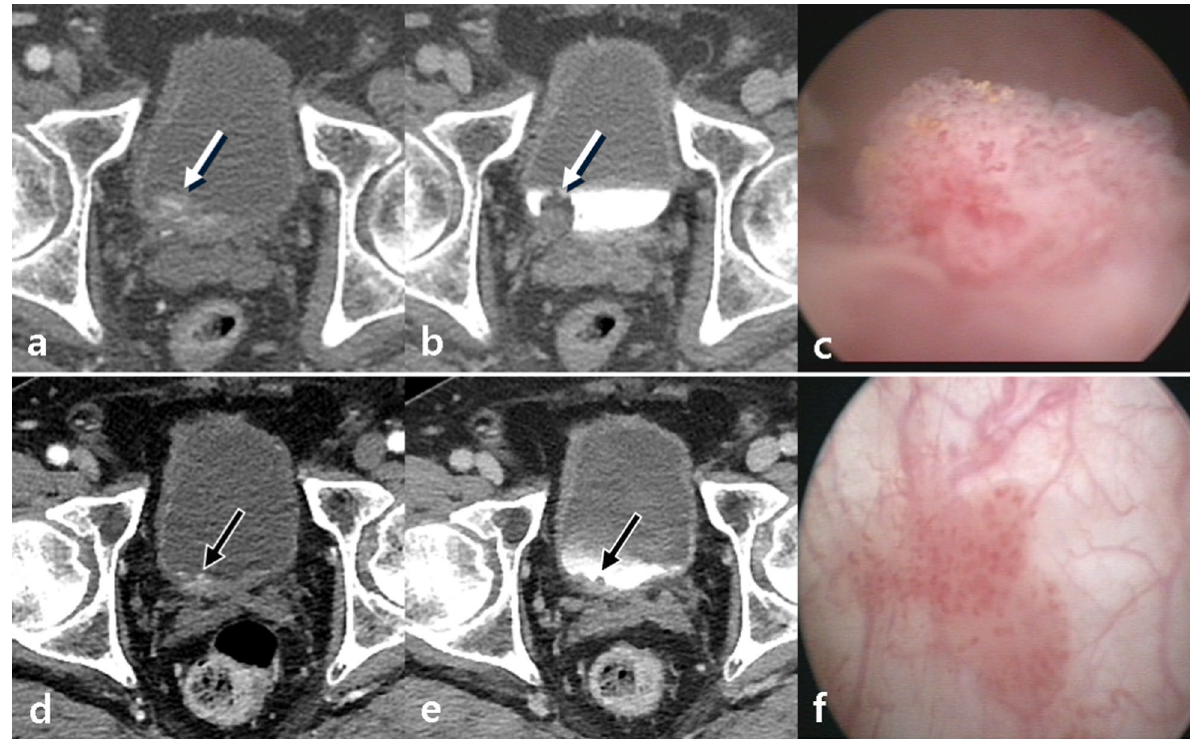
Fig. 2 Urothelial and excretory phase scans of CT urography in initial and recurred urothelial carcinomas. a Axial urothelial phase CT image of a 70‑year‑old man shows a small hyper‑enhancing polypoid mass (arrow) that enhances more than normal bladder mucosa. b Axial excretory phase CT image shows the enhancing bladder lesion (arrow) but is less pronounced compared to the urothelial phase. c The nodule was also identified using conventional cystoscopy. Taken at the 6‑month follow‑up after transurethral resection of the bladder tumor, this axial urothelial phase CT image d shows an intraluminal hyper‑enhancing mass (arrow) on the posterior wall of the bladder, the same as the initial tumor site. e Axial excretory phase CT of the patient shows that the mass is a filling defect (arrow) within the bladder lumen. f The nodule was detected using conventional